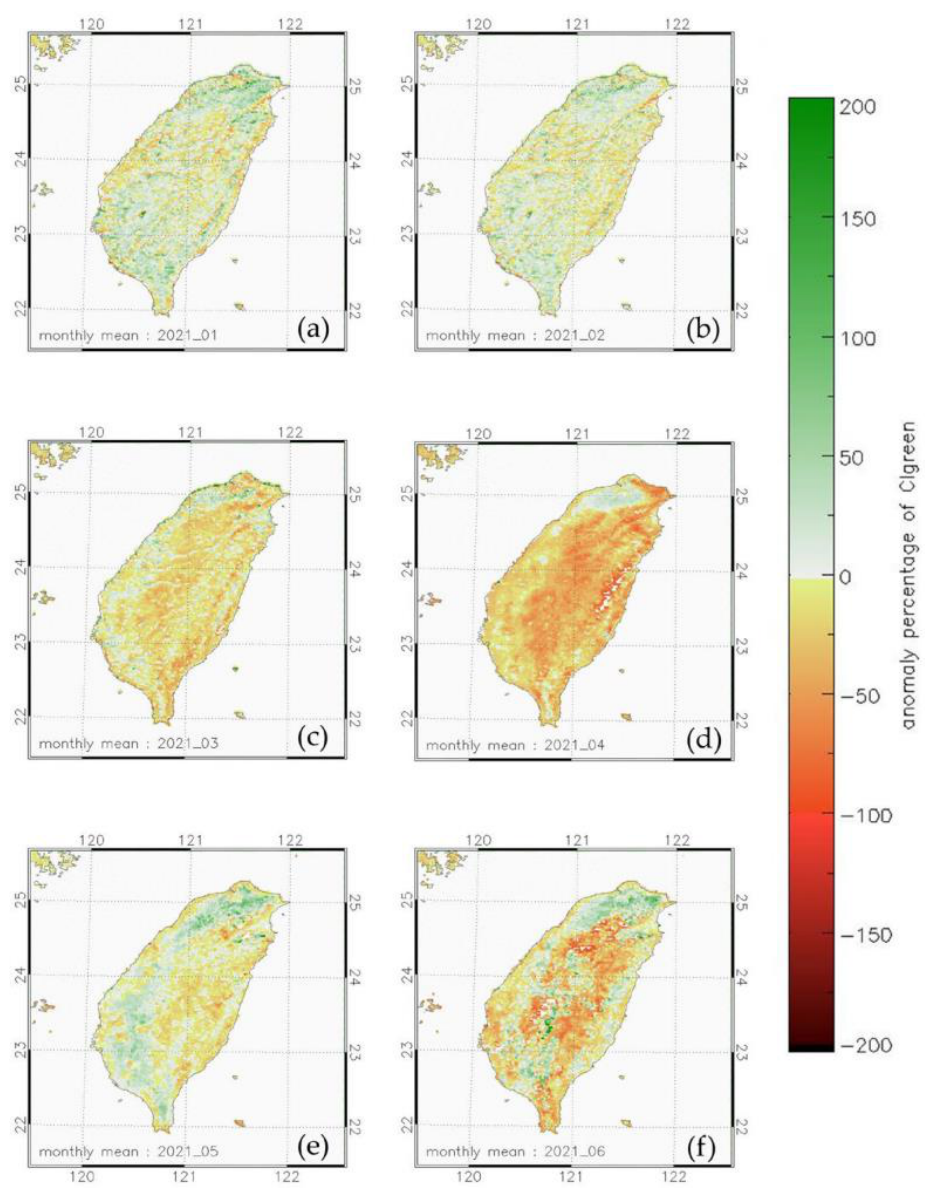
Figure 1. The anomaly of percentage of CI green over Taiwan from January to June 2021 (from ( a – f )). Color scale is shown at the right. Latitude and longitude are labelled on the border.